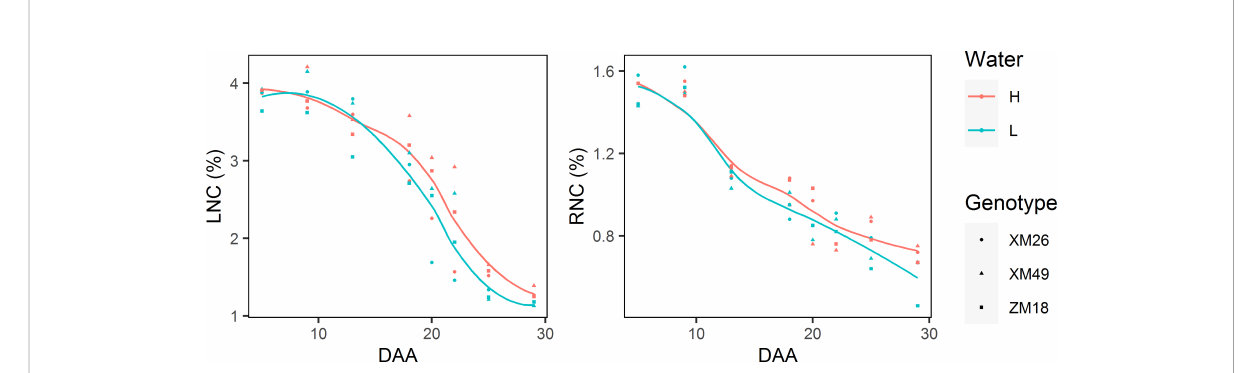
FIGURE 9 The dynamics of leaf nitrogen concentration (LNC) and rachis nitrogen concentration (RNC) of different winter wheat genotypes grown under different levels of irrigation. Lines represent values fi tted using the “ loess ” method and the points denote observations. DAA, days after anthesis; H, high-water treatment; L, low-water treatment; XM26, Xinmai-26; XM49, Xinmai-49; ZM18,